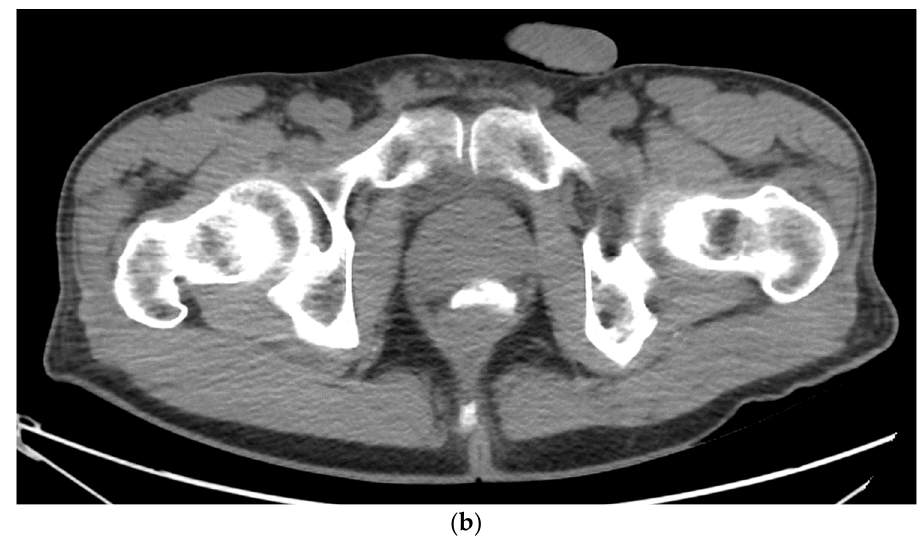
Figure 3. ( a ). Sagittal view after injection of SpaceOAR Vue shows 1 cm of distance gained between the rectum and prostate at the level of the mid-gland. ( b ). Axial view after injection of SpaceOAR Vue shows 1.1 cm of distance gained between the rectum and prostate at the level of the mid-gland.